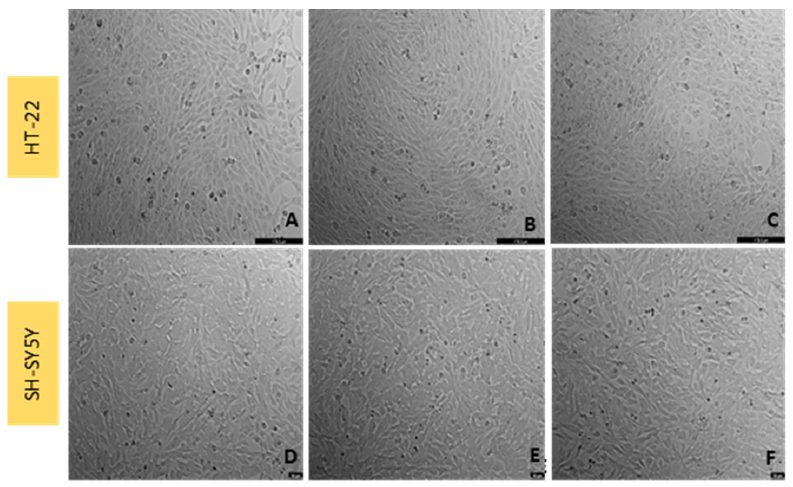
Figure 4. Representative images (100 × total magnification) of HT-22 and SH-SY5Y cells. Cells were treated with ( A , D ) vehicle (0.1% DMSO) ( B , E ) mirtazapine 0.01 μ M, ( C , F ) mirtazapine 20 μ M.